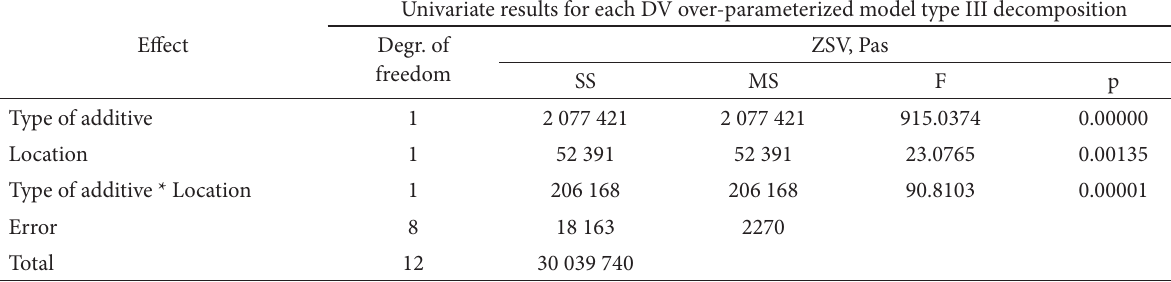
Table 3. The evaluation of the influence of the qualitative factors on the zero shear viscosity (ZSV) at 60 °C